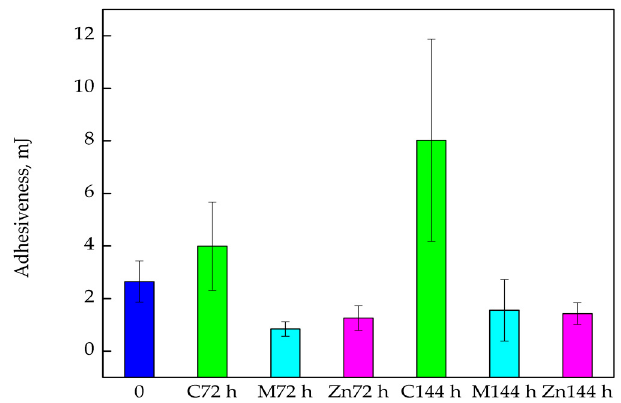
Figure 7. The Adhesiveness of the cod fillets after 72 and 144 h of storage.